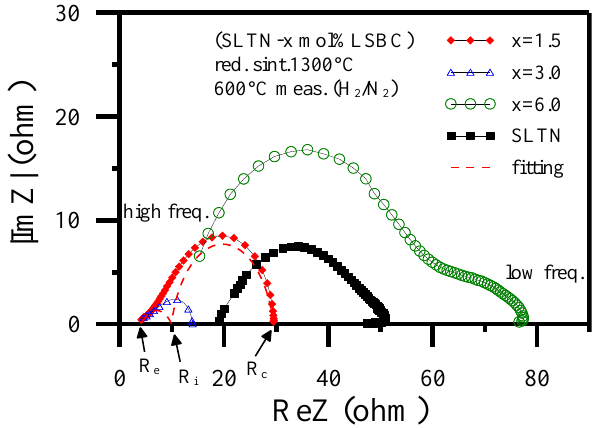
Figure 9. The AC impedance spectra for SLTN-x mol% LSBC core – shell anodes after 1300 °C/3 h sintering in activated carbon-reduction atmosphere then measured at 600 °C in H 2 /N 2 atmosphere